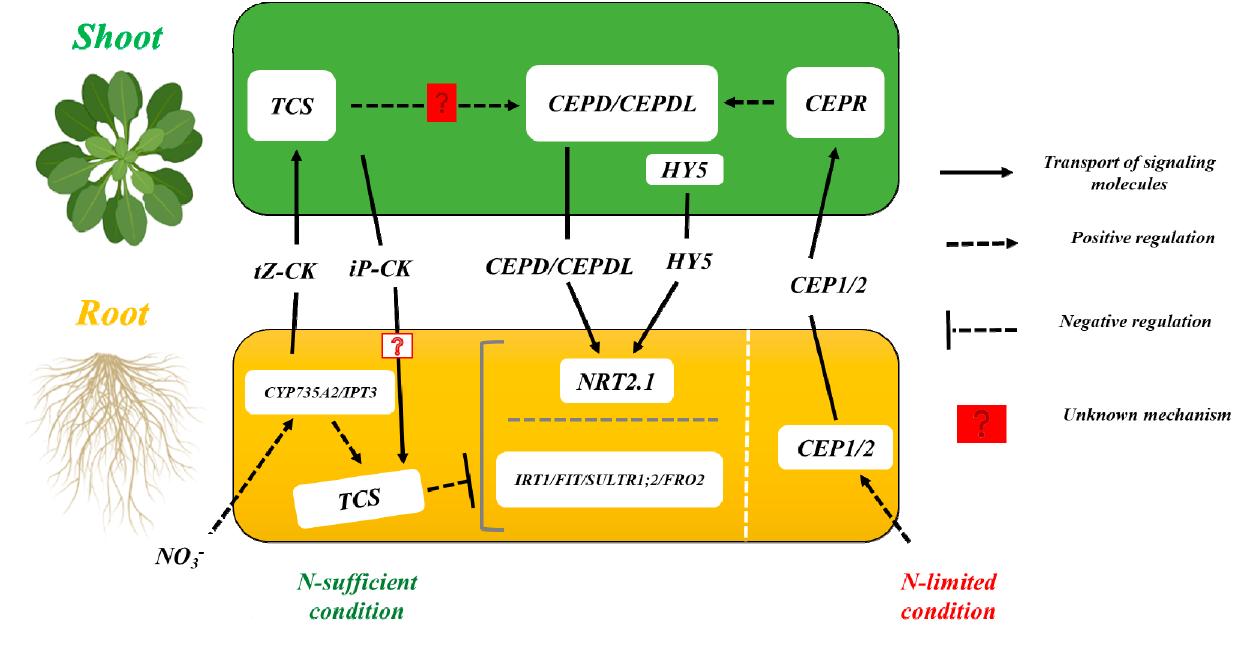
Figure 1. Cytokinin signaling pathways and other signaling players for nutrient uptake regulation. TCS—two-way component system for cytokinin signaling under nitrogen stress [66].